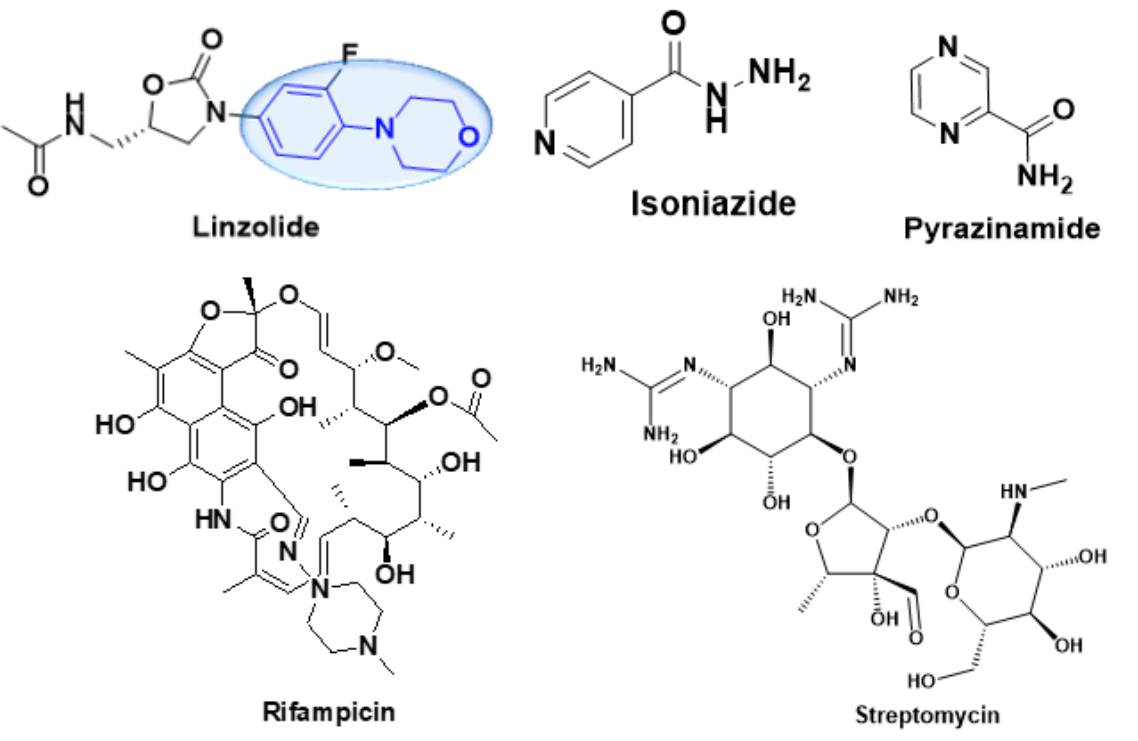
Figure 4. Commercially available anti-tubercular drugs.